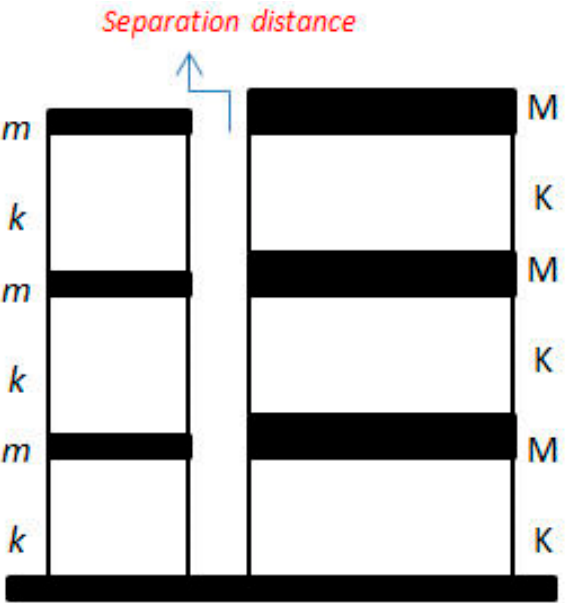
Figure 2. Schematic models of two adjacent three-story buildings. Table 1. Properties of five different models.